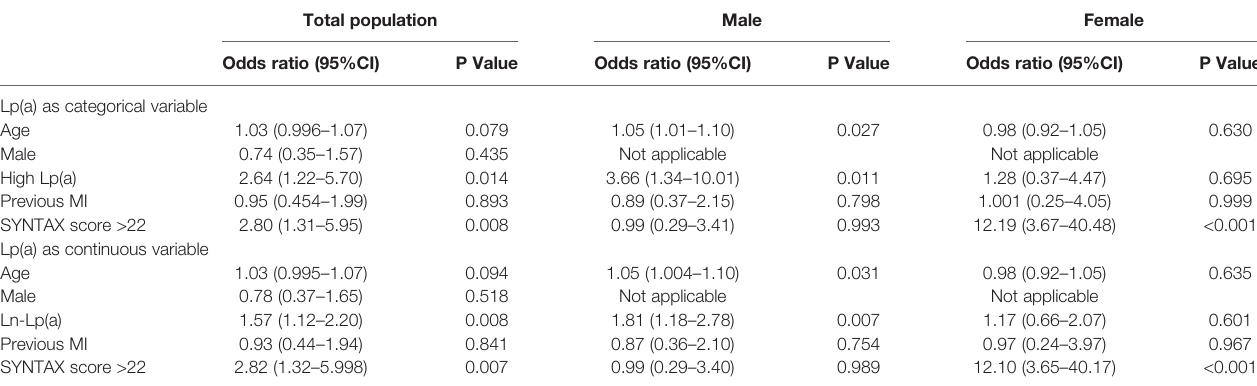
TABLE 4 | Multivariate logistic regression analysis for peri-procedural myocardial infarction.